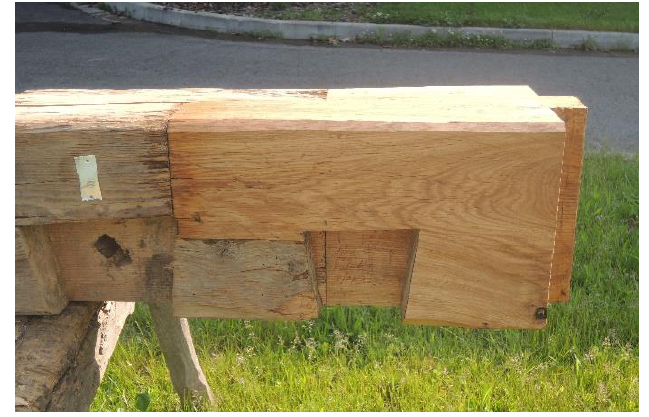
Figure 10. The bottom of the damaged beam (III) after the repair.